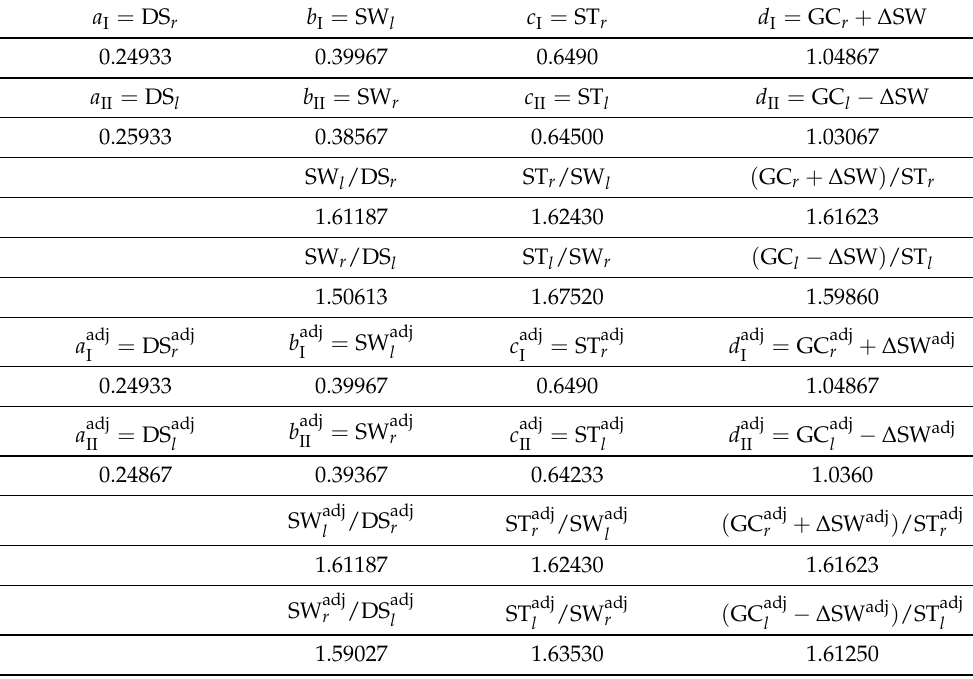
Table 5. Experimental data concerning the elements (in seconds) of the sequences I and II in (3) and their adjoint versions I adj , II adj in (4) for the healthy subject 2 (DS x = 0.12633 s, DS y = 0.123